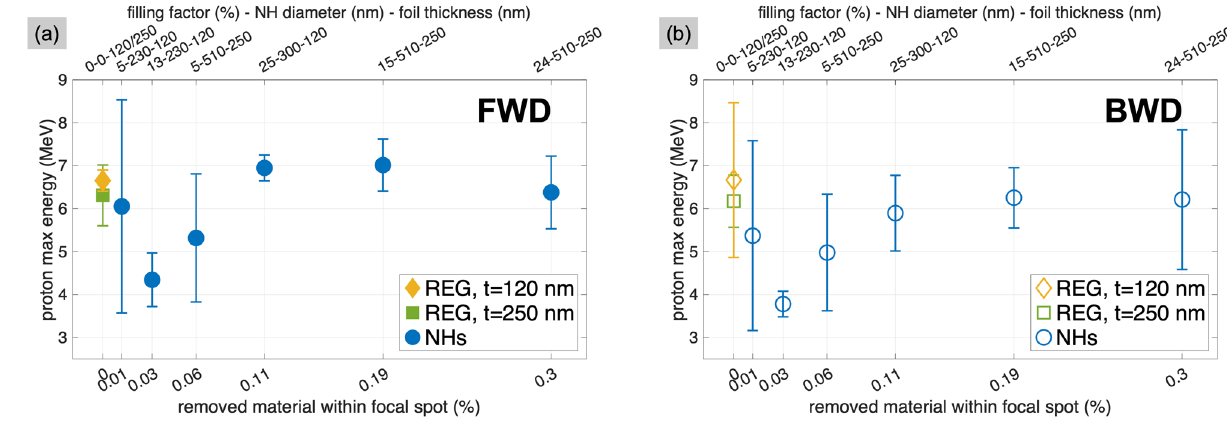
Figure 2. Proton maximum energies obtained from NH targets and regular foils, both in the FWD ( a ) and BWD ( b ) direction. For NHs, the amount of removed material is defined by the area occupied by NHs within the area covered by the laser focal spot. All target parameters (filling factor ρ , NH diameter d , foil thickness t ) are listed in the top x-axis.